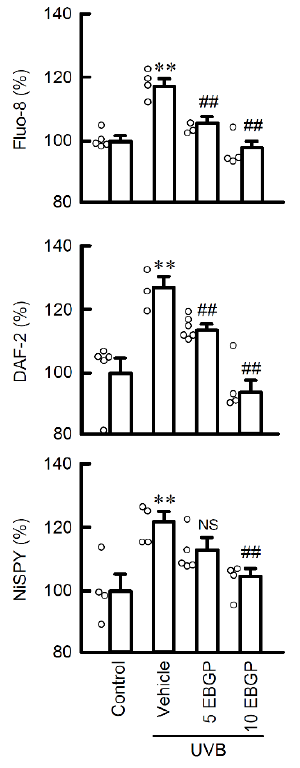
Figure 2. Effect of EBGP on Ca 2+ influx and RNS generations in the weak UVB-exposed cells. After exposure to weak UVB, the cells were cultured for 3 h. The cells were incubated with 5 μM Fluo-8 AM, 5 μM DAF-2DA, or 5 μM NiSPY-3 for 30 min. Nonirradiated cells were used as control. The fluorescence intensities of Fluo-8, DAF-2, and NiSPY-3 were measured using a microplate reader. n = 3–6. ** p < 0.01 vs. control. ## p < 0.01 and NS p > 0.05 vs. vehicle.